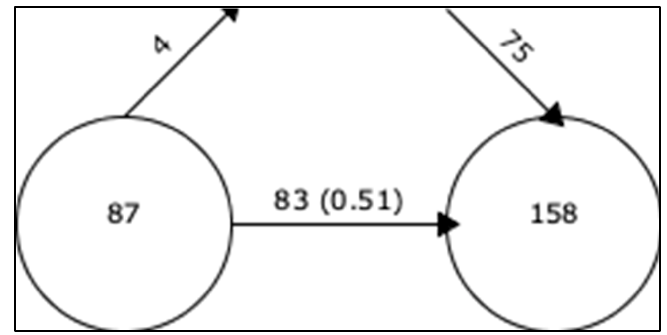
Figure 7. Overlapping map.